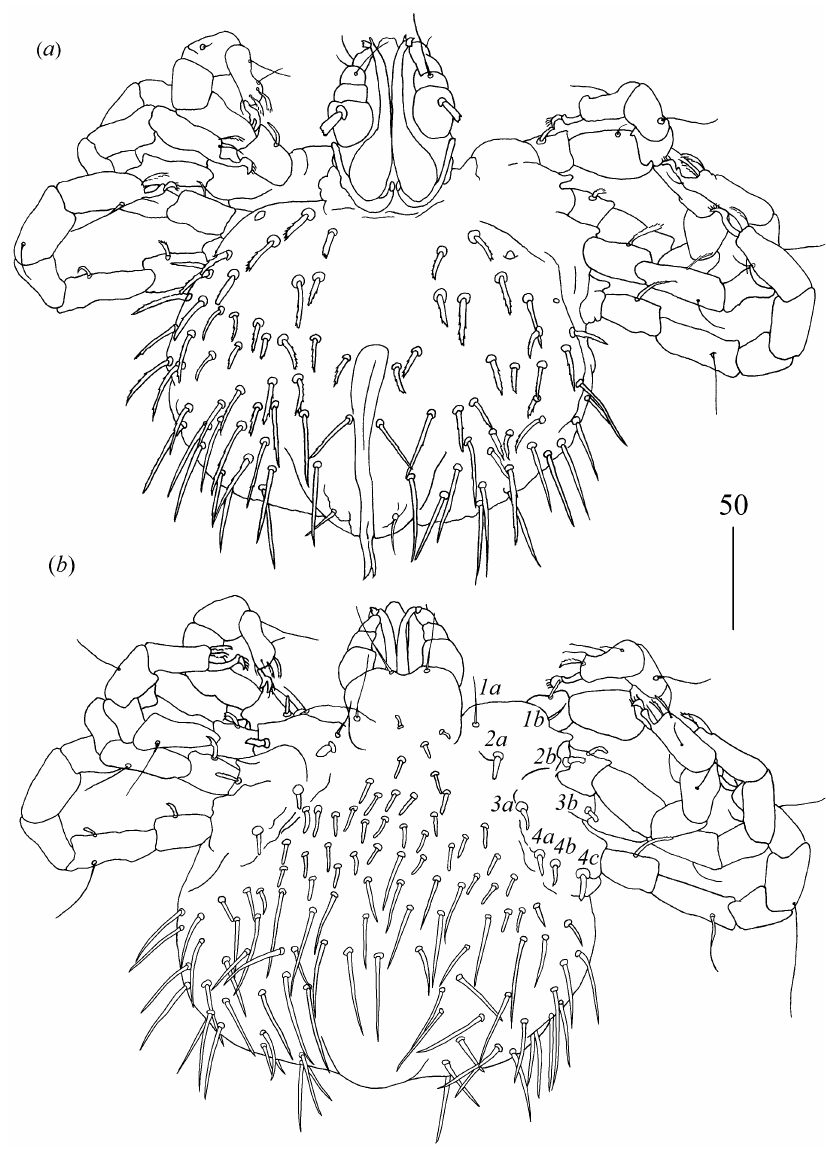
Figure 17. Geckobia indica Hirst, 1917, male: ( a ) in dorsal view; ( b ) in ventral view.